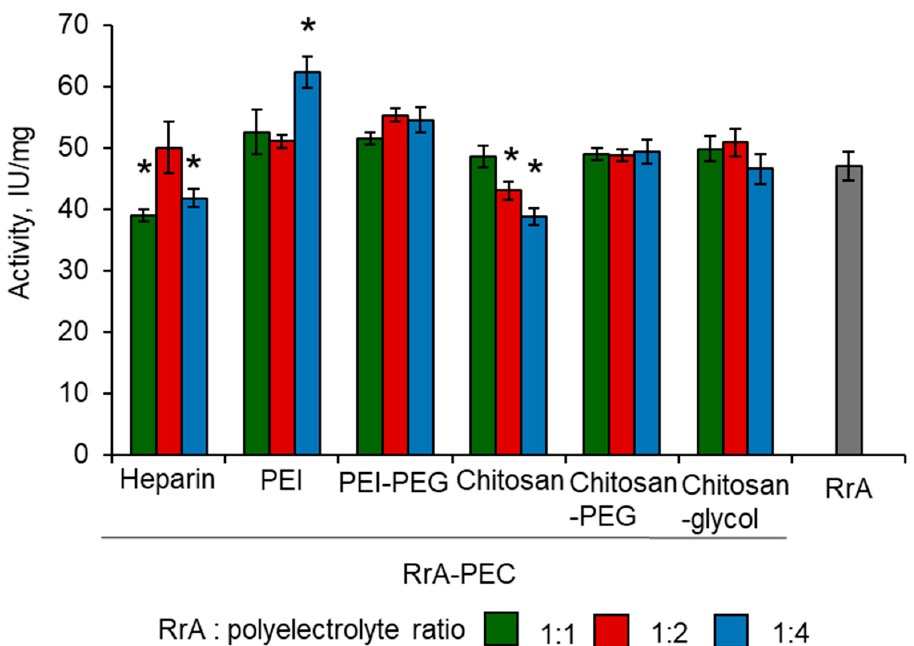
Figure 4. The enzymatic activity of RrA-PEC to 20 mM L-asparagine in 10 mM PBS pH 7.5. PEC, polyelectrolyte complex; PEG, polyethylene glycol; PEI, polyethyleneimine; RrA, Rhodospirillum rubrum L-ASNase. N = 4. * p ≤ 0.05 relative to the activity of non-complexed RrA. Table 4. K M and V max values for native RrA and PEC–RrA-PEI within a pH range of 6.5–9.0 in a 5 mM citrate–phosphate–borate